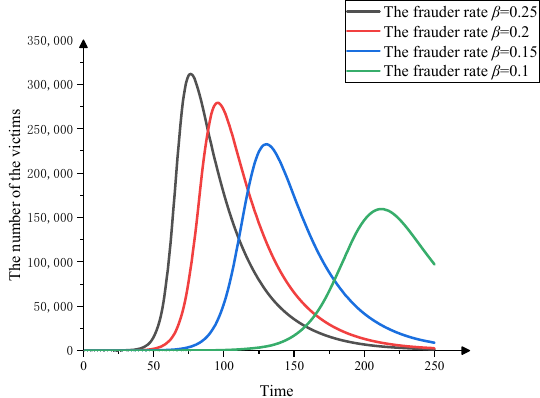
Figure 10. Impact of reduced fraud rates on fraud dissemination.